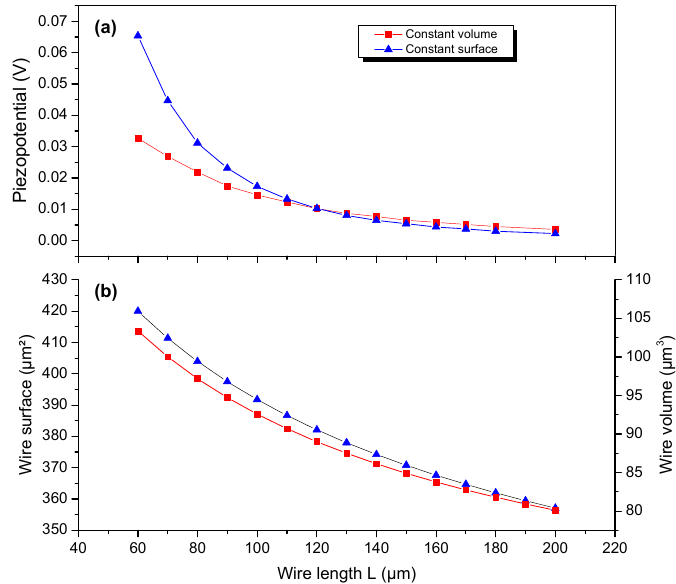
Figure 6. ( a ) Piezo-potential calculated at center of the wire as a function of the wire length for α = 1° and ρ = 10 cm curvature radius; ( b ) the related variation of the wire surface and volume.